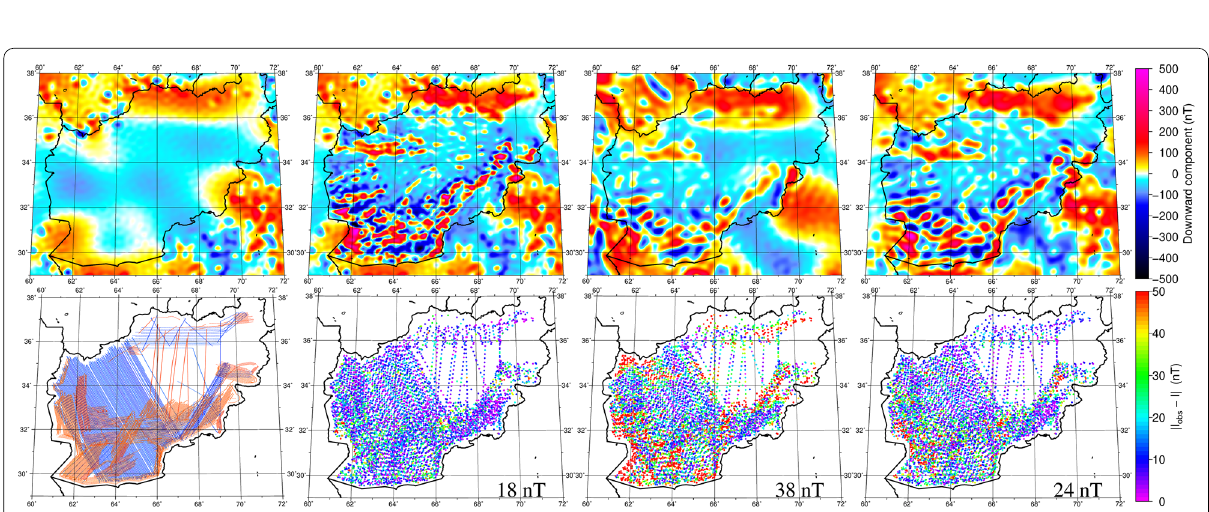
Fig. 9 Lithospheric field update at the level of Afghanistan. Top left: prior mean downward component in 2006.0 expanded up to ℓ = 1000 . Bottom left: locations of airborne intensity measurements taken in 2006 (blue dots) and 2008 (red dots). The second to the fourth map on the top show different models of the downward component of the lithospheric field. These are, respectively, from from left to right, the posterior mean expanded up to ℓ = 2000 , the EMM model by Maus (2010) taken up to ℓ = 790 and posterior mean truncated at ℓ = 790 . Under each solution, the absolute value of the difference between measured intensities and predicted ones is shown. For predictions, the Kalmag mean core field was included. The values given on the bottom left of these maps correspond to the r.m.s. values of the differences between the model and the